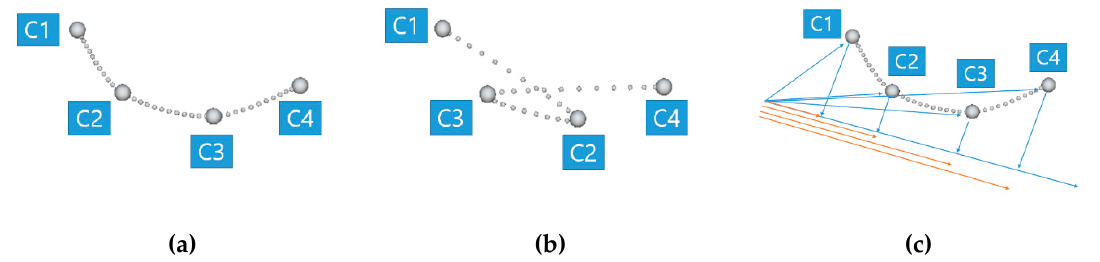
Figure 10. Control point alignment for Catmull–Rom spline: ( a ) aligned control points; ( b ) unaligned control points; ( c ) control point alignment through PCA.